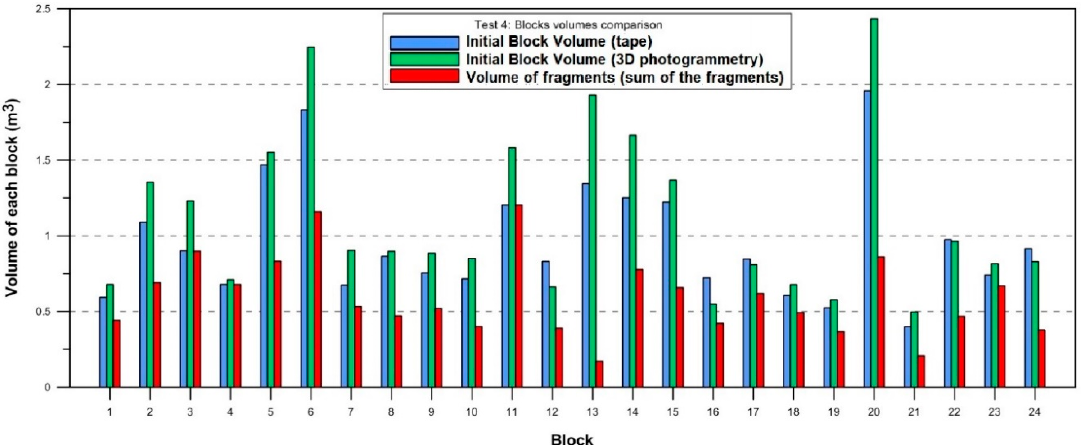
Figure 9. Initial block volume measured with a tape, initial block volume from 3D models and sum of the generated fragments’ volume, in test 4.